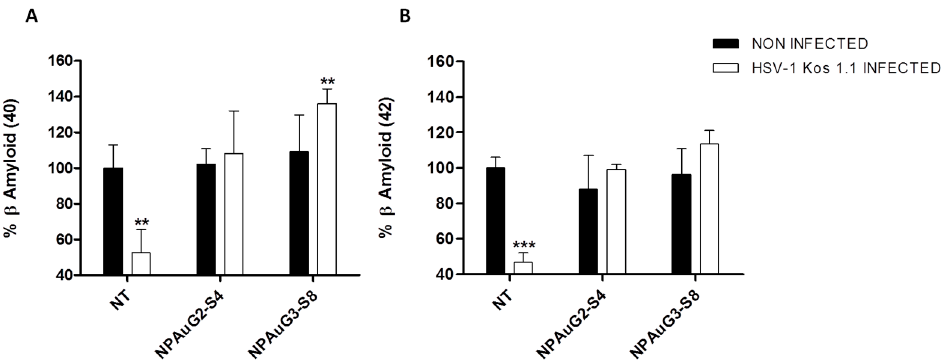
Figure 7. Secreted A β 40 and A β 42 levels on SK-APP-D1 cells. SK-APP-D1 cells were treated with NPAuG2-S4 or NAPuG3-S8 and non-infected ( A ) or infected with HSV-1 ( B ) at MOI 1, 1 h at 37 ◦ C. Quantitative analysis of extracellular amyloid- β 1-40 or A β 40 and 1-42 or A β 42 levels were made by ELISA. Data represent mean ± SD of at least three independent experiments performed by